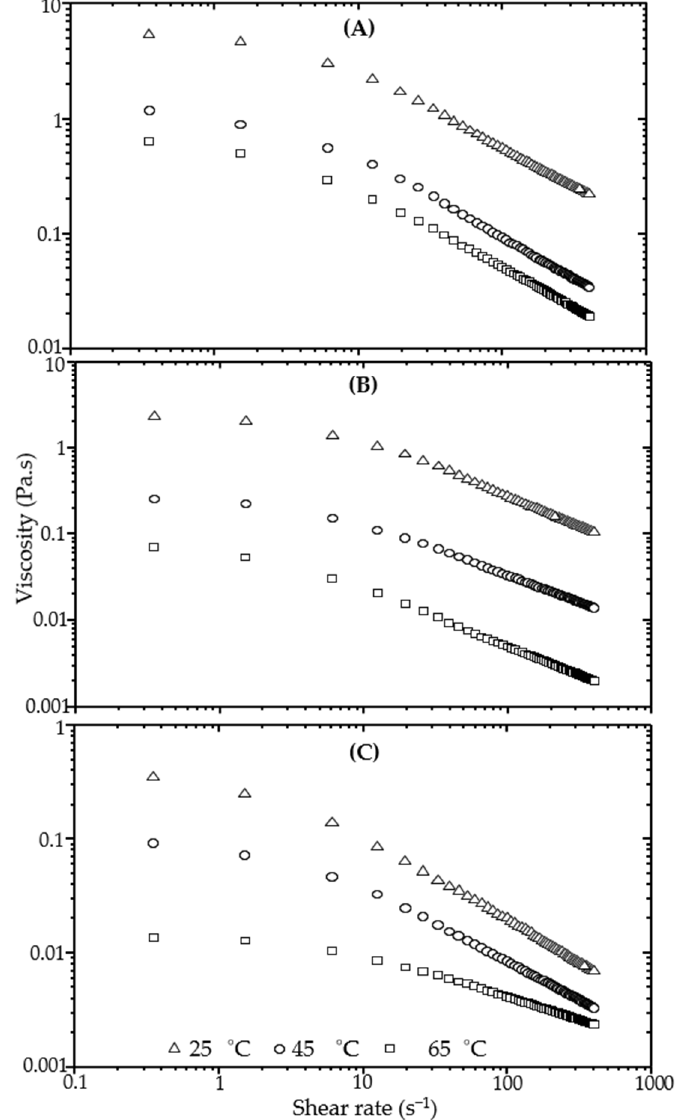
Figure 5. Influence of temperature on shear viscosity of xanthan-DW ( A ), xanthan-IW ( B ) and xanthan-RW solutions ( C ).